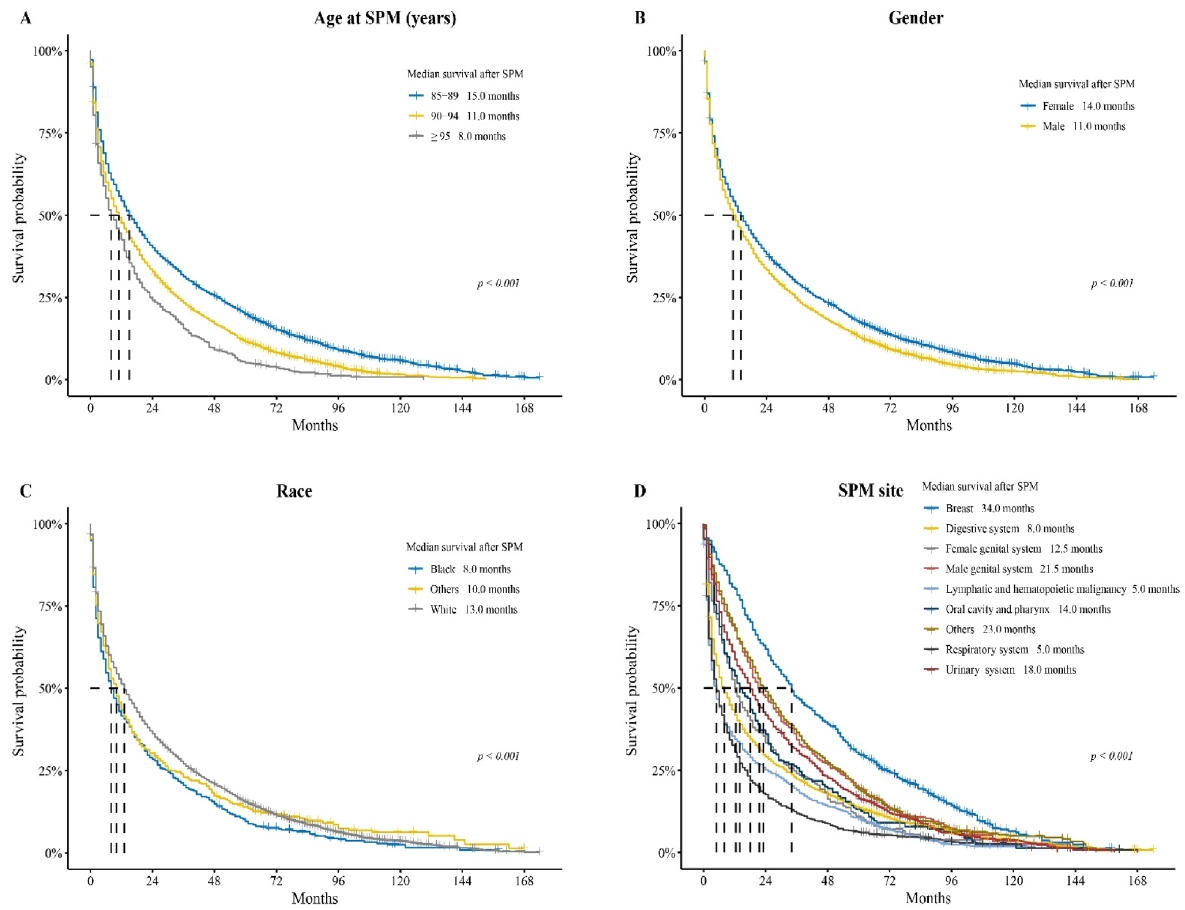
Figure 4. Analysis of survival after developing a SPM stratified by ( A ) age at SPM, ( B ) gender, ( C ) race, and ( D ) SPM site. SPM, second primary